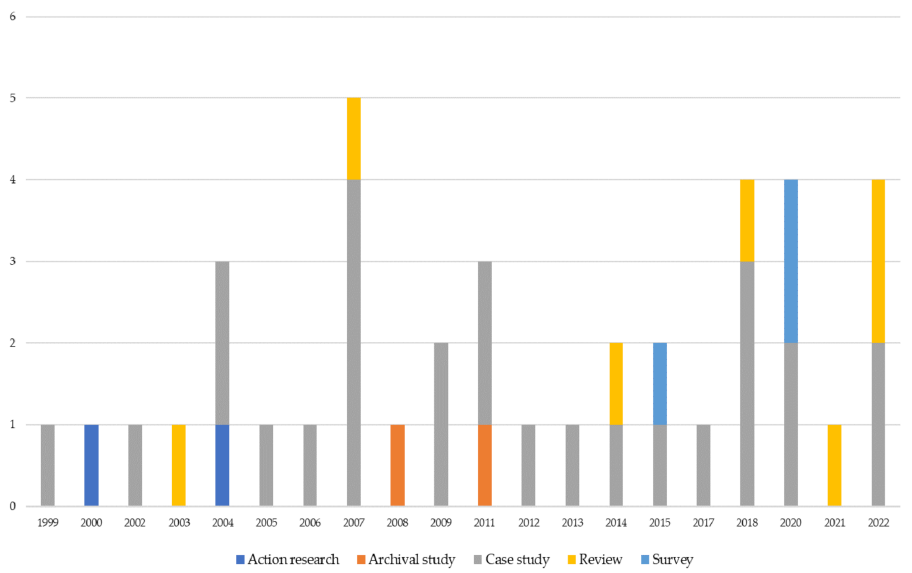
Figure 6. Distribution of papers by methodologies and years.